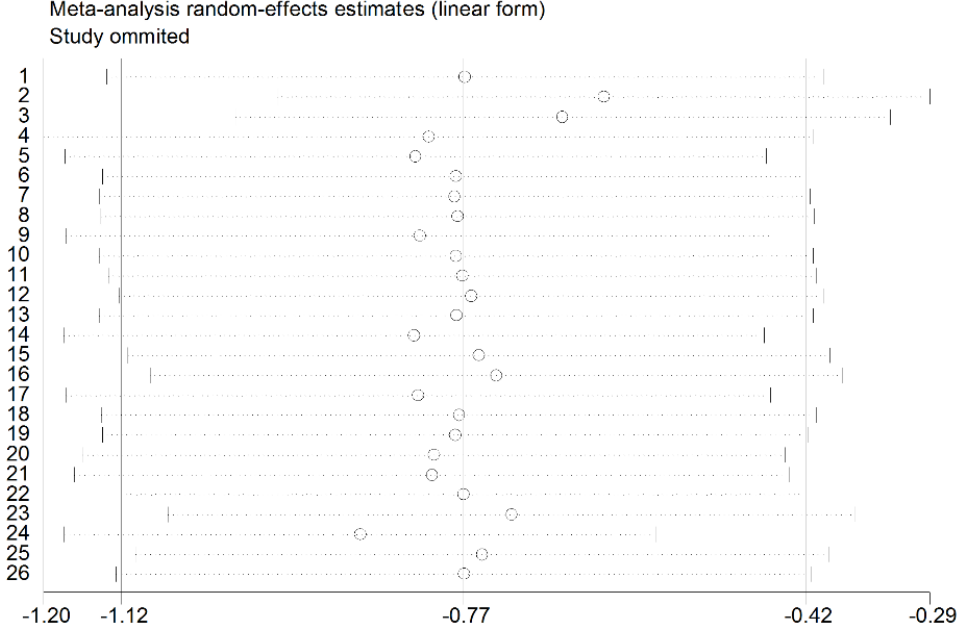
Figure 4. The sensitivity analysis for the association between vitamin D levels and Graves’ disease by the random effects